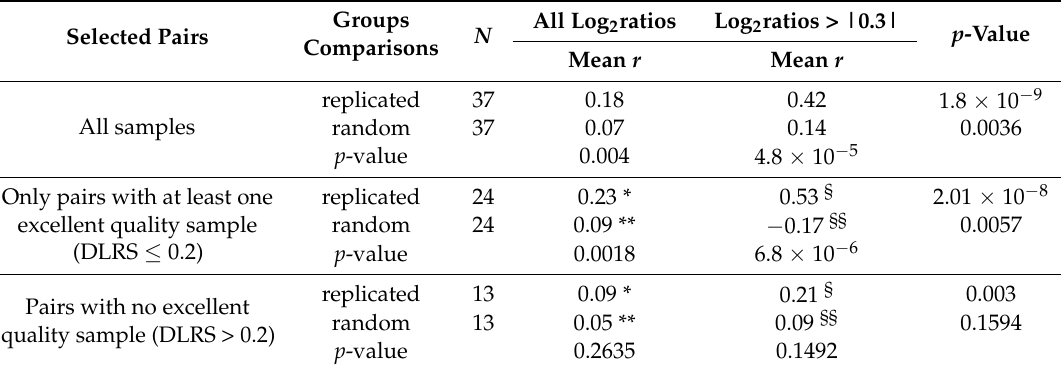
Table 1. Log 2 ratios